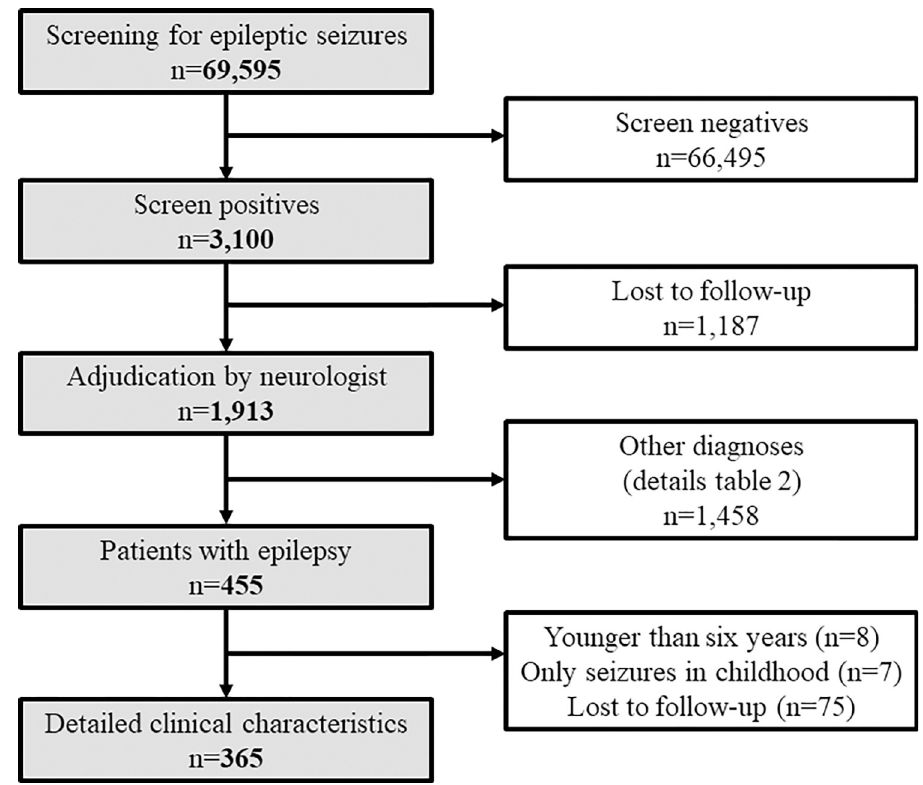
Fig 1. Flowchart of the